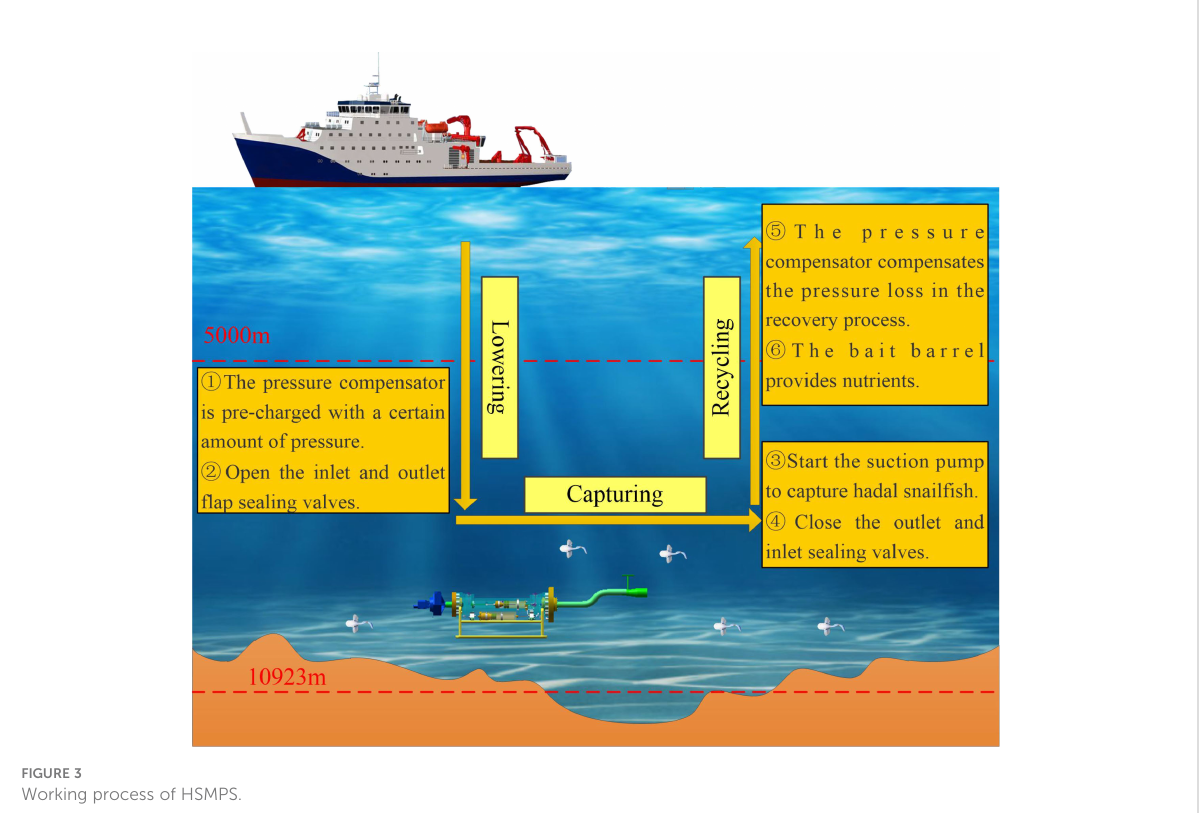
FIGURE 3 Working process of